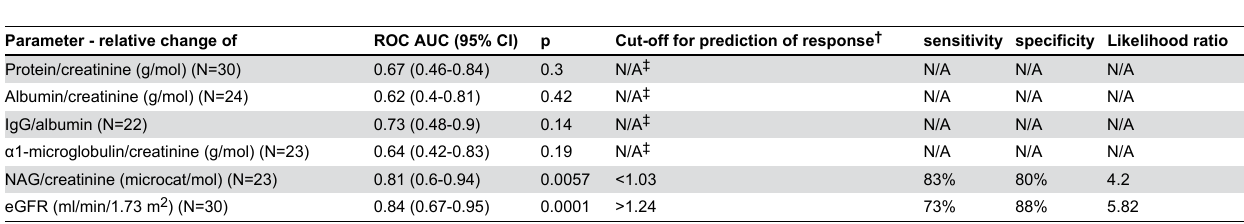
Table 3. The ROC analysis of relative changes in various clinical parameters (measured at baseline and after 3 months of induction therapy) for predicting renal response at 6 months.